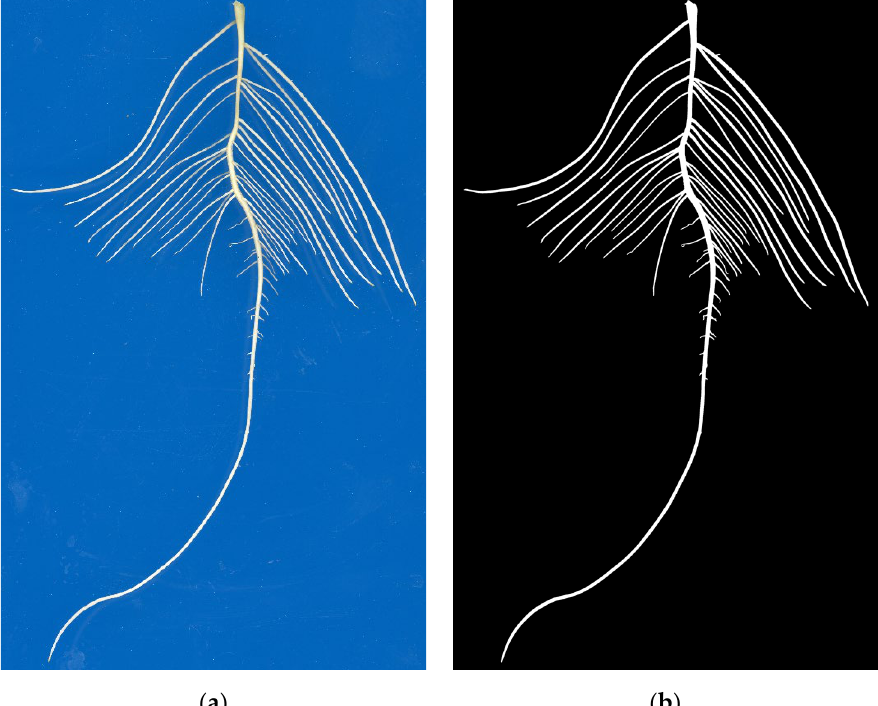
Figure 2. Image annotation of soybean root system. ( a ) Original image; ( b ) Annotated image.